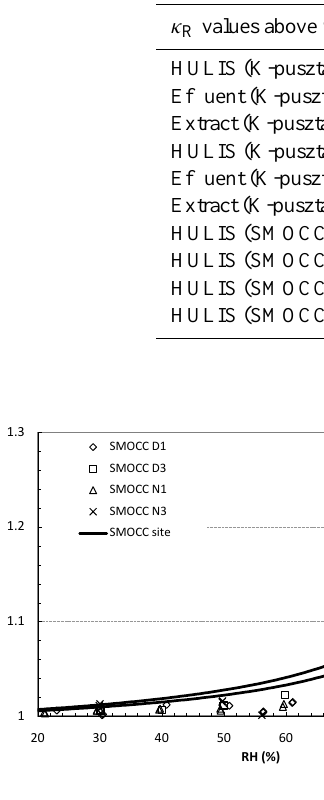
Fig. 3. Measured hygroscopic growth of 100nm HULIS aerosol particles collected during the SMOCC campaign without pre- humidification of the aerosol. The growth factors are corrected ac- cording to efflorescence measurements, which indicate a slight re- structuring of the particles. The two SMOCC site parameterizations represent growth measured on site during the time periods, averaged as internal mixture and weighted by mass (to simulate the soluble ions collected on a filter and re-suspended). The average over all six periods ranges between the two solid